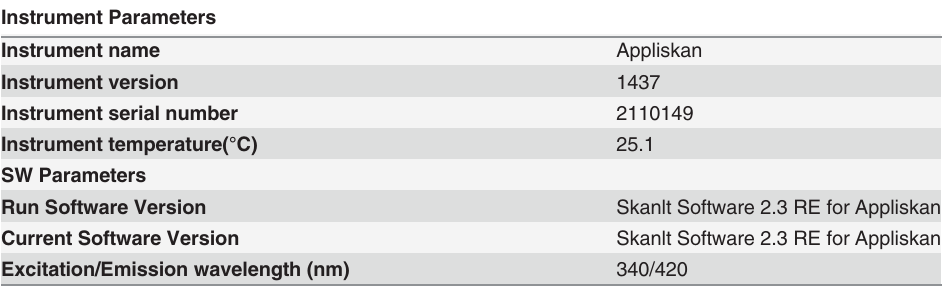
Table 2. Operating conditions for molecular fl uorescence